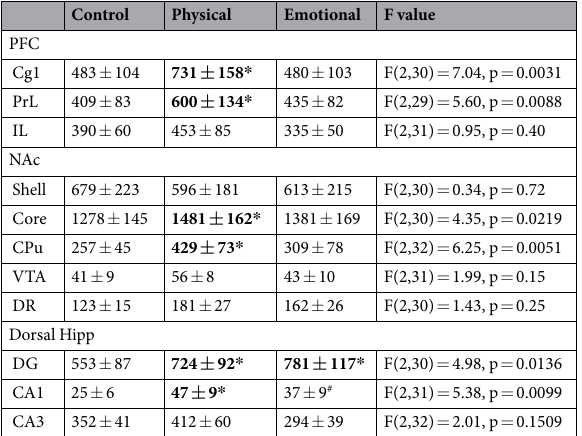
Table 1. Mean number ( + / − SEM) of Δ FosB immunoreactive nuclei per mm 2 in brain areas of control, physical stress, and emotional stress mice 1 hr after social interaction testing (~24 hours after last day of 10 d of chronic social defeat stress), n = 9–12 mice/group. Cg1, cingulate cortex; CA1/3, cornu ammonis 1/3; CPu, caudate putamen; DG, dentate gyrus; DR, dorsal raphe; Hipp, hippocampus; IL, infralimbic cortex; NAc, nucleus accumbens; PFC, prefrontal cortex; VTA, ventral tegmental area. * p < 0.05, compared to control. # non- significant